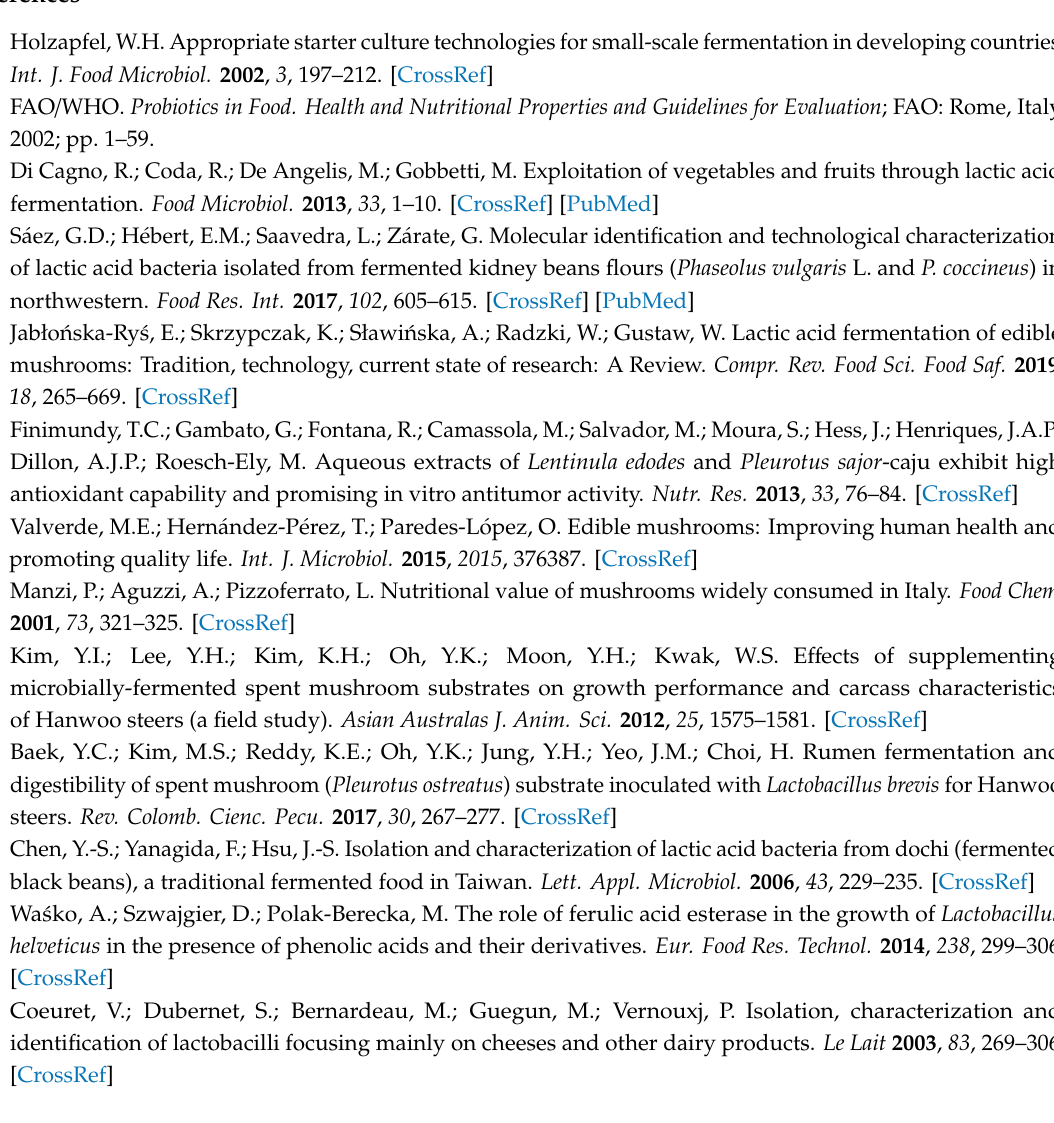
Table S1: The results of comparison of the obtained 16S rRNA sequences of analyzed isolates with sequences available in the GenBank database.; Table S2: The comparison of the profiles of carbohydrate fermentation exhibited by the tested isolates.; Figure S1: Electrophoretic separation the products of amplification rec A gene (line M1 and M2—molecular markers expressing mass in bp; line 1 —negative control sample; line 2— EK3; line 3